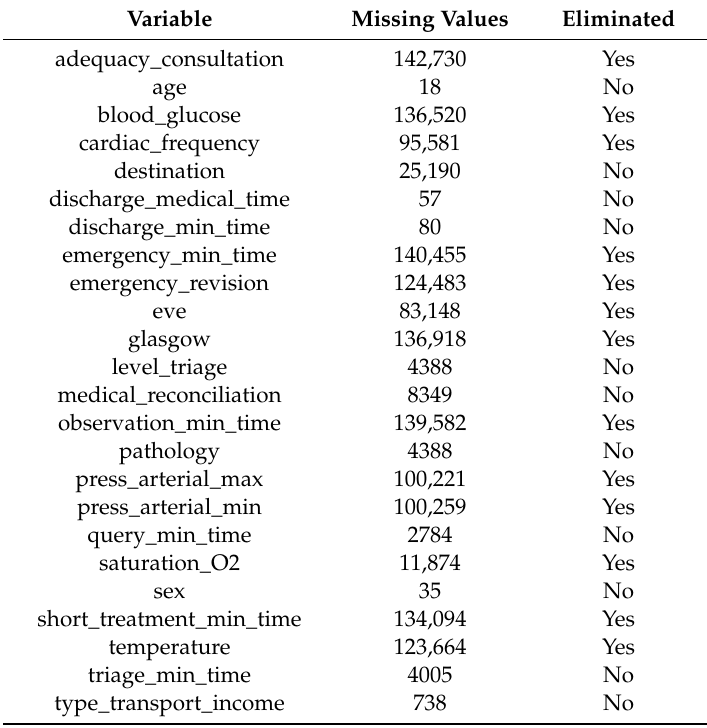
Table 6. Variable interval